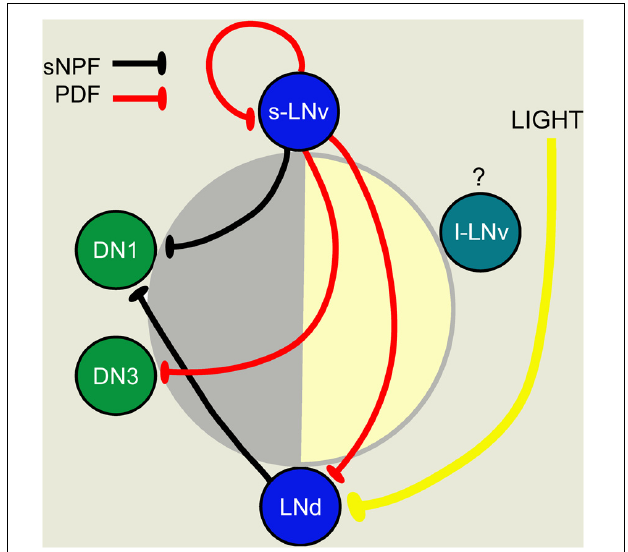
FIGURE 6 | A scheme depicting PDF-, sNPF-, and light-mediated interactions that orchestrate sequential Ca 2 + activity phases in different pacemaker groups. Each pacemaker group is represented by one neuron. The position of cells in the day-night circle (yellow–gray) indicates the peak phase of Ca 2 + . Both PDF and sNPF signals inhibit the target neurons and suppress these from being active when the sender neurons (s-LNv for PDF; s-LNV and LNd for sNPF) are active. Light cycles act together with PDF to delay Ca 2 + phases in LNds. This figure was redrawn from Liang et al. (2017).